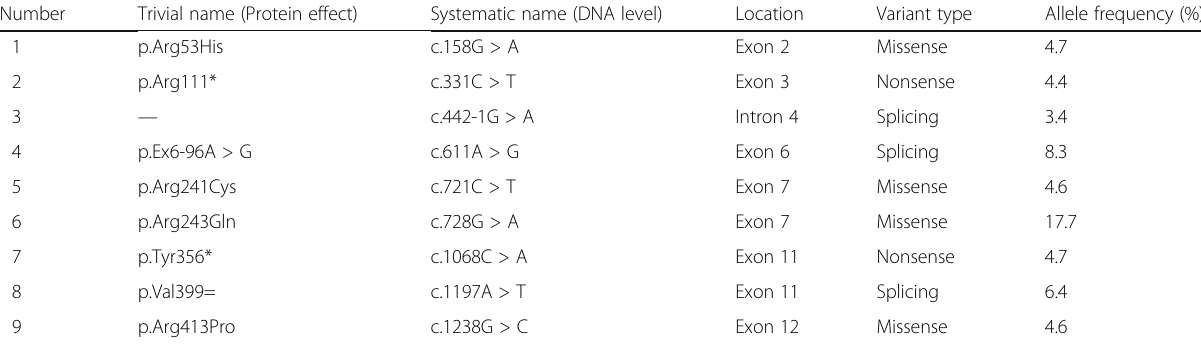
Table 1 High frequency variants of the PAH gene